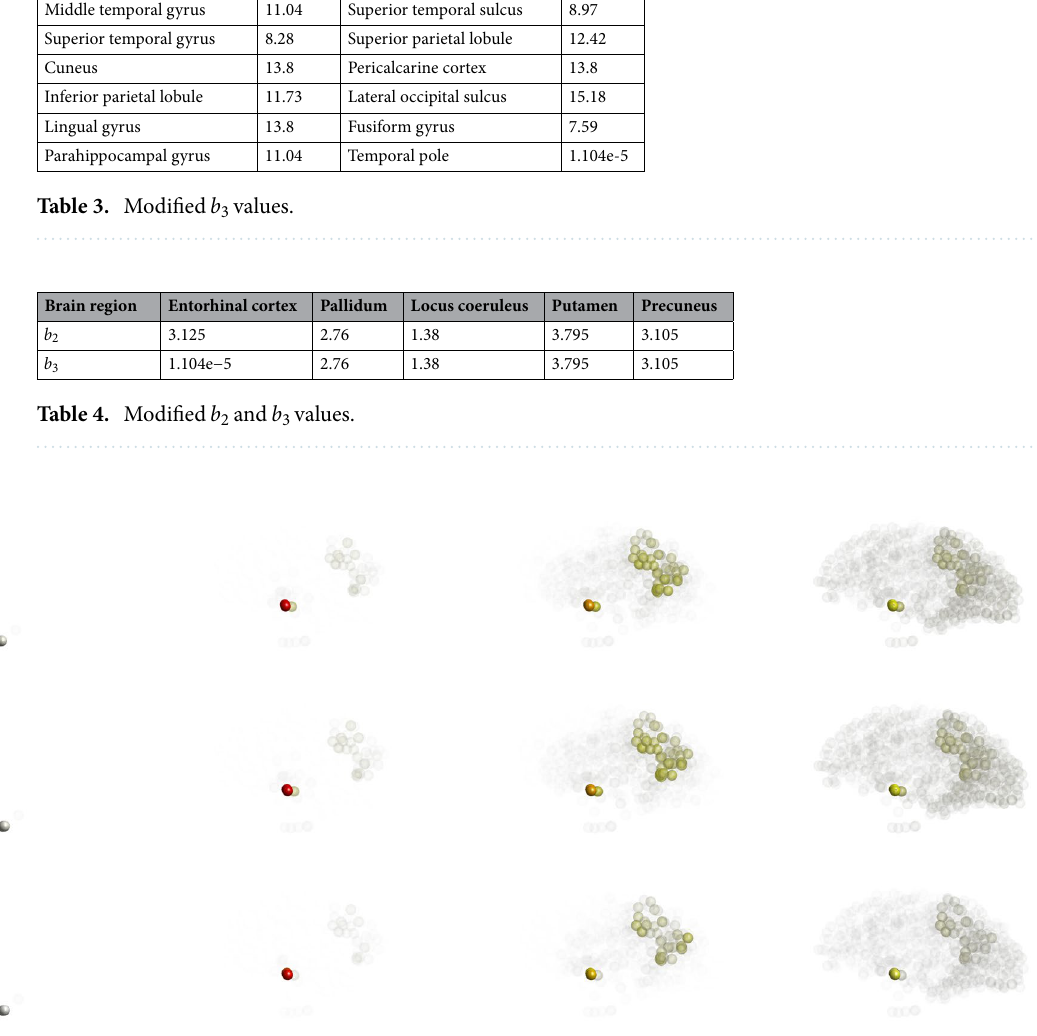
Figure 7. (Color online) Toxic- τ P distributions in the brain over time (left to right: t = 10, 20, 50 and 100) for the mixed tauopathy. Upper panel is corresponding to the local model, while middle and lower panels are corresponding to the nonlocal model with η = 0.5 and η = 0.25 ,